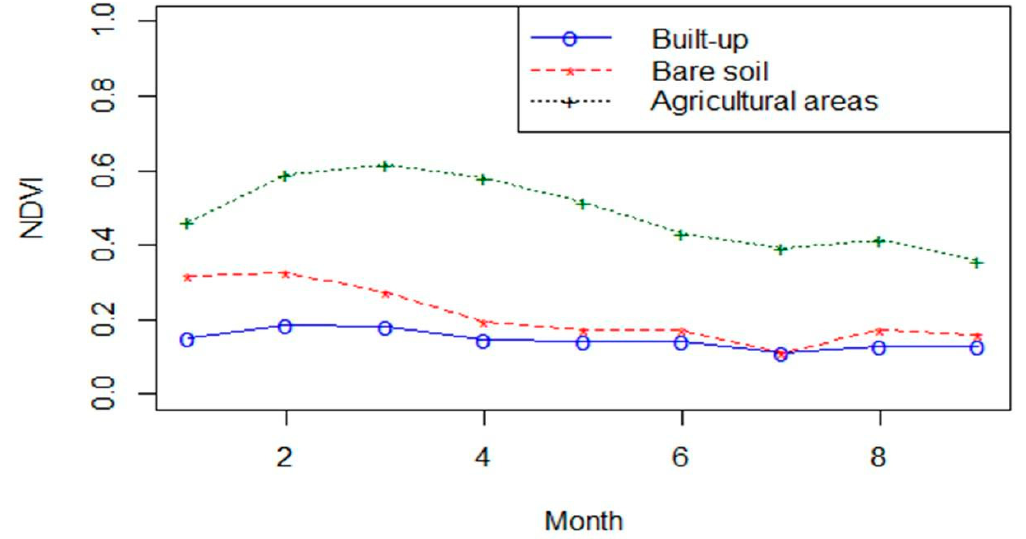
Figure 2. Normalized difference vegetation index (NDVI) profile evolution of bare soil, built-up, and agricultural areas in the Bekaa Valley, in 2017.